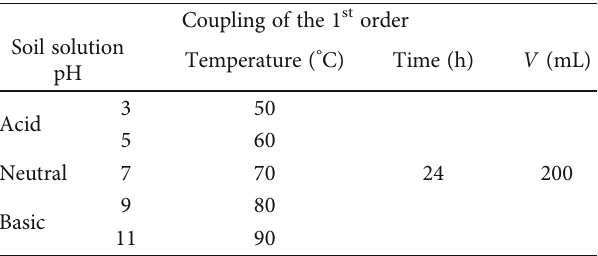
Figure 2: Experimental assembly of the 1 st order coupling. Table 1: Soil solution pH and temperatures of the coupling of the 1 st order of the